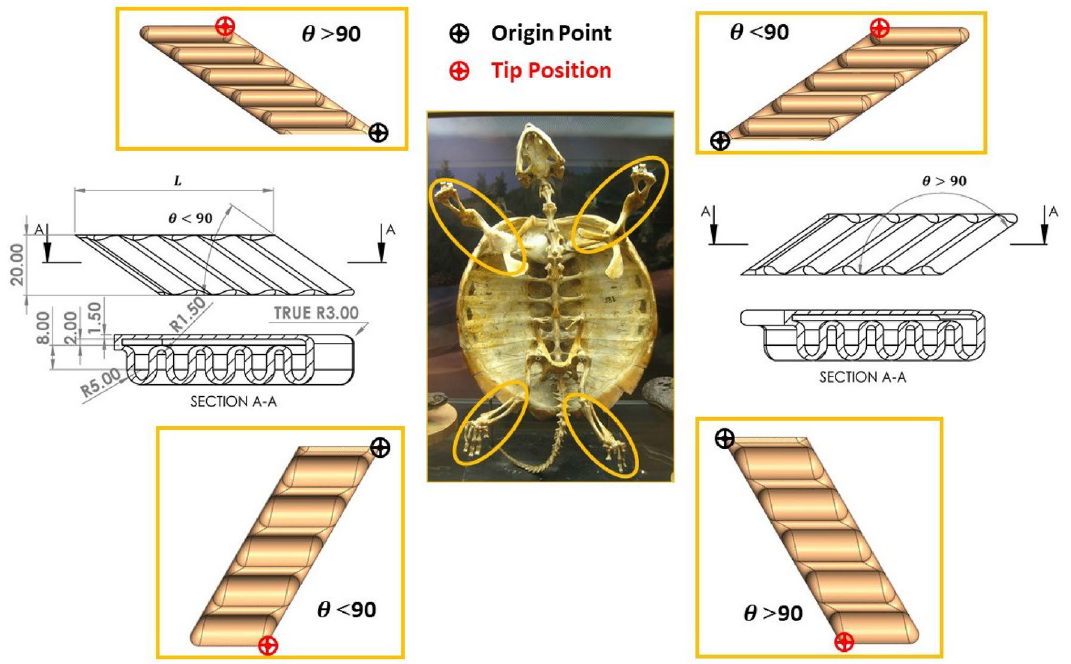
Figure 1. The similarities between the turtle flipper’s anatomy and the soft oriented angle pneumatic actuator with the CAD designs of SPA. The figure shows that the front flippers have wider rotation range than the back ones. The designed actuators motion is from morphology of the real turtle. Every flippers has its origin point and tip position point that the analysis is implemented based on it.